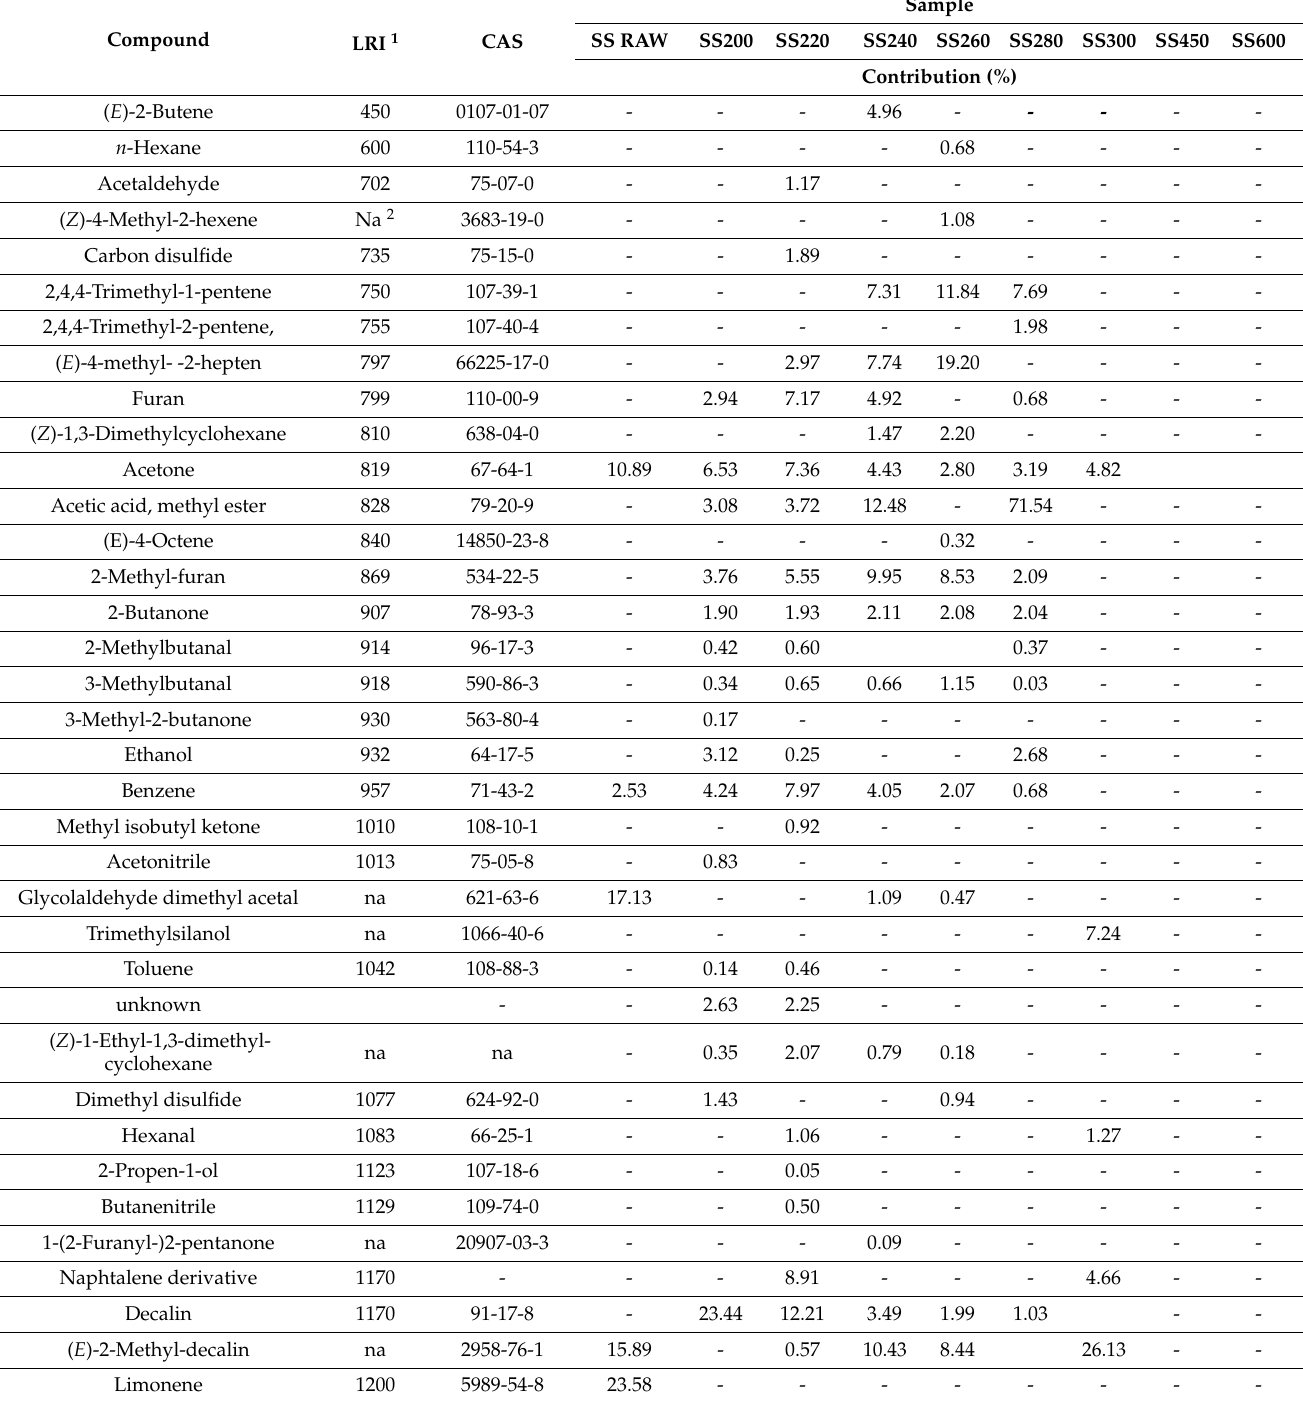
Table 2. The changes in volatile organic compound profiles caused by different temperatures during the biochar produc- tion